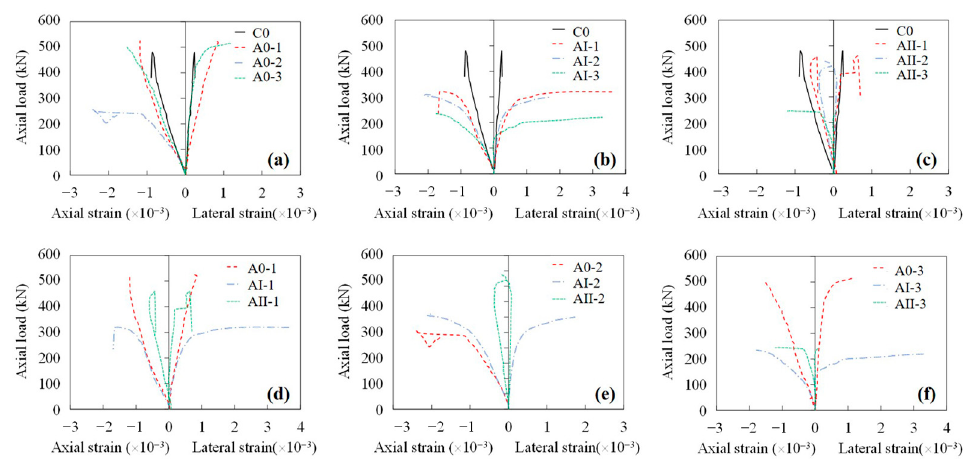
Figure 10. Axial load–axial strain and axial load–lateral strain responses of column specimens. ( a ) Unloaded specimens with different corrosion degrees, ( b ) Specimens subjected to 30% ultimate load and various corrosion degrees, ( c ) Specimens subjected 60% ultimate load and various corrosion degrees, ( d ) Specimens subjected 16-days accelerated corrosion and various sustained load, ( e ) Specimens subjected to 31-days accelerated corrosion and various sustained load, ( f ) Specimens subjected to 63-days accelerated corrosion and various sustained load.